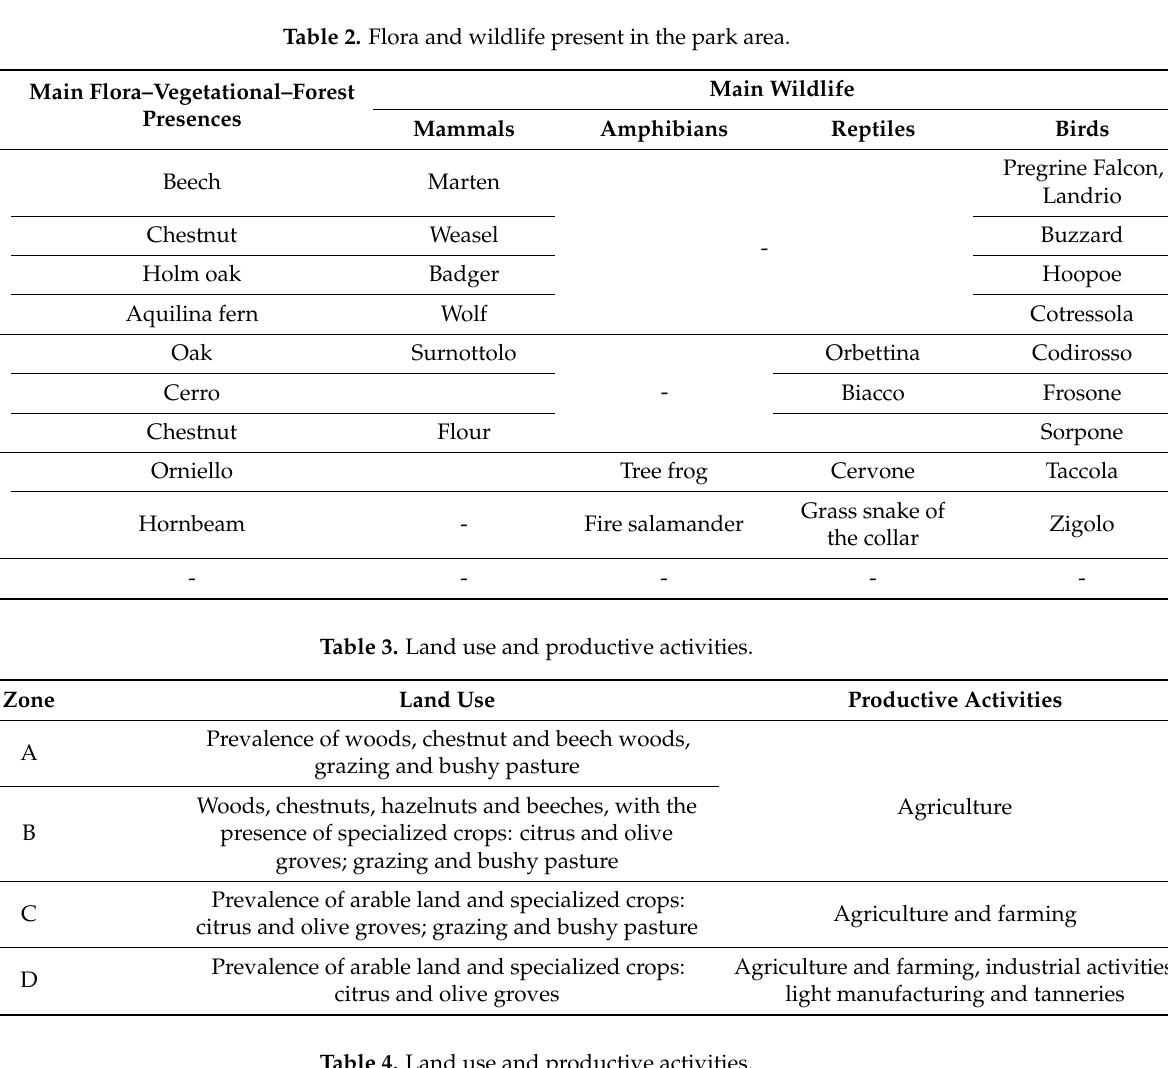
Table 4. Land use and productive